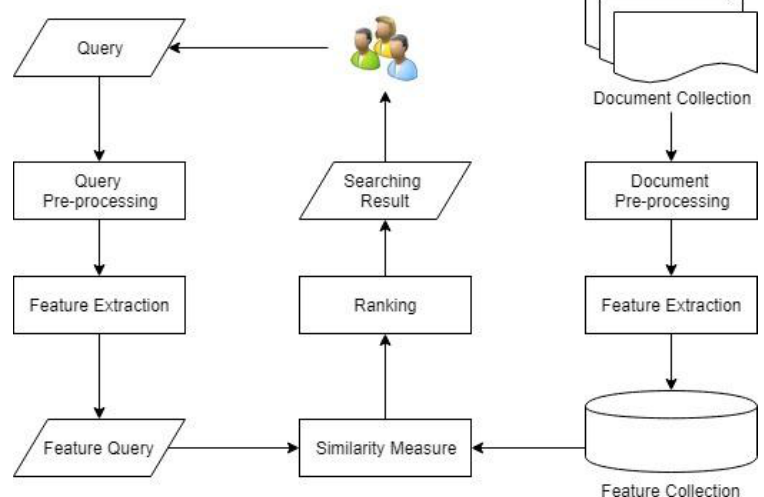
Fig. 1 Architecture of General Information Retrieval